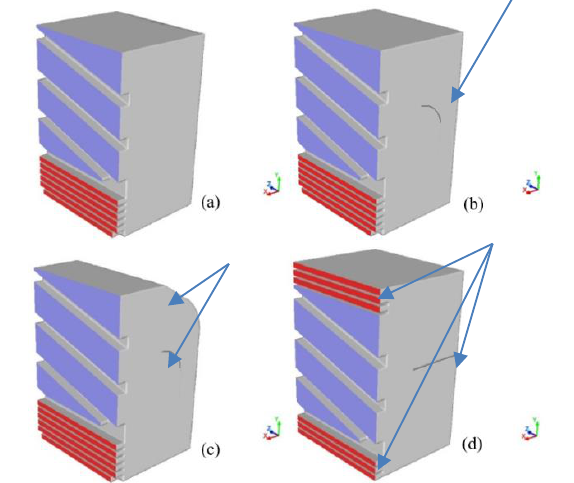
Fig. 10. Acoustic pressure fields [dB]: (a) without guide vanes, (b) with one stream guide vane, (c) with two stream guide vanes, (d) with stream